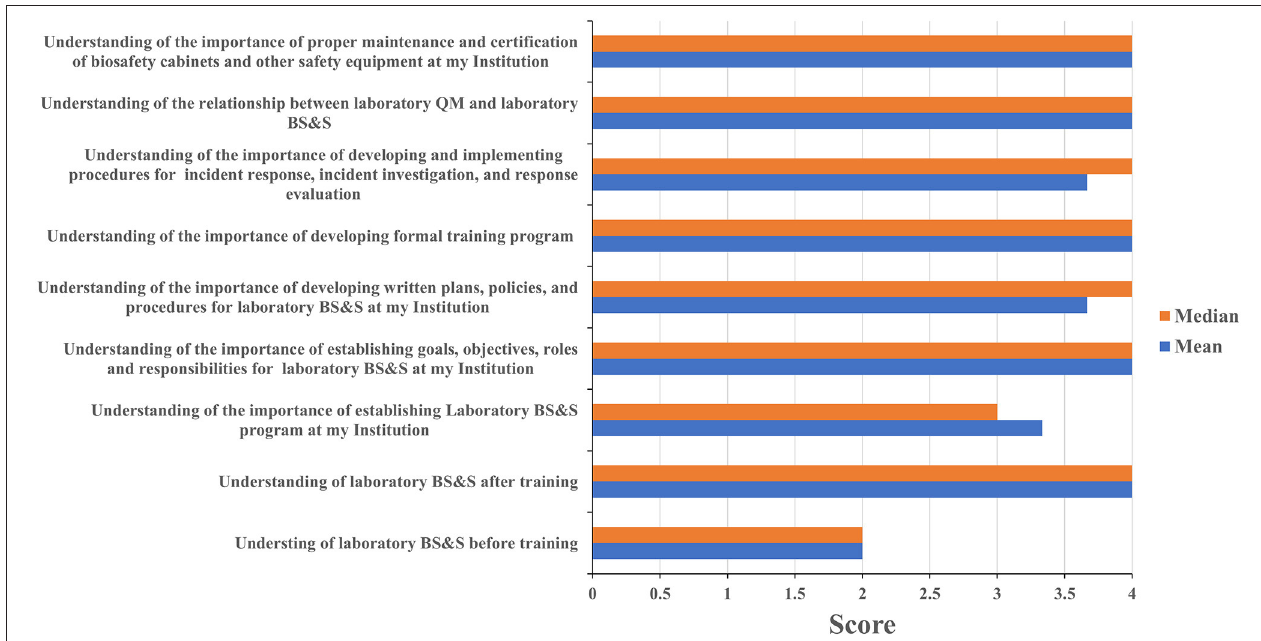
FIGURE 3 | Leadership training impact. Questionnaires were designed for self-evaluation of leadership participant’s knowledge impact on their professional activities. Trainees were asked to score 1 to 4 with 1 being the least score and 4 the highest. The mean and median were then calculated. MoH, ministry of health; BS&S, biosafety and biosecurity; QM, quality management.